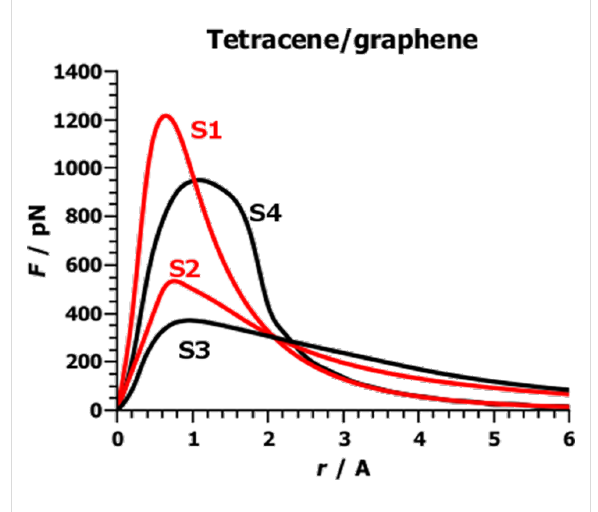
Figure 8: The slope functions for the separation of tetracene from graphene for the four separation modes. Red: Rigid adsorbate. Black: Flexible